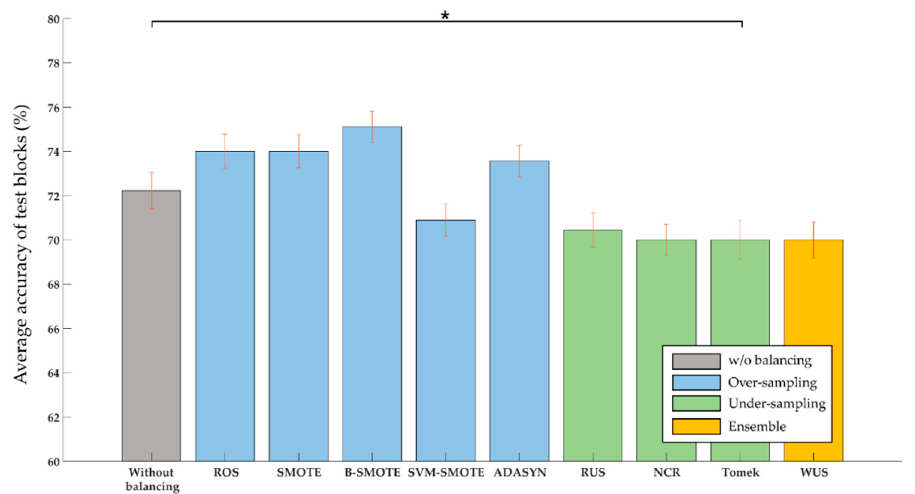
Figure 4. Total accuracy over all three home appliances in poor BCI performers without balancing as well as with various sampling techniques. Red vertical bars denote standard error of mean and * marks denote statistical significance ( p < 0.05).